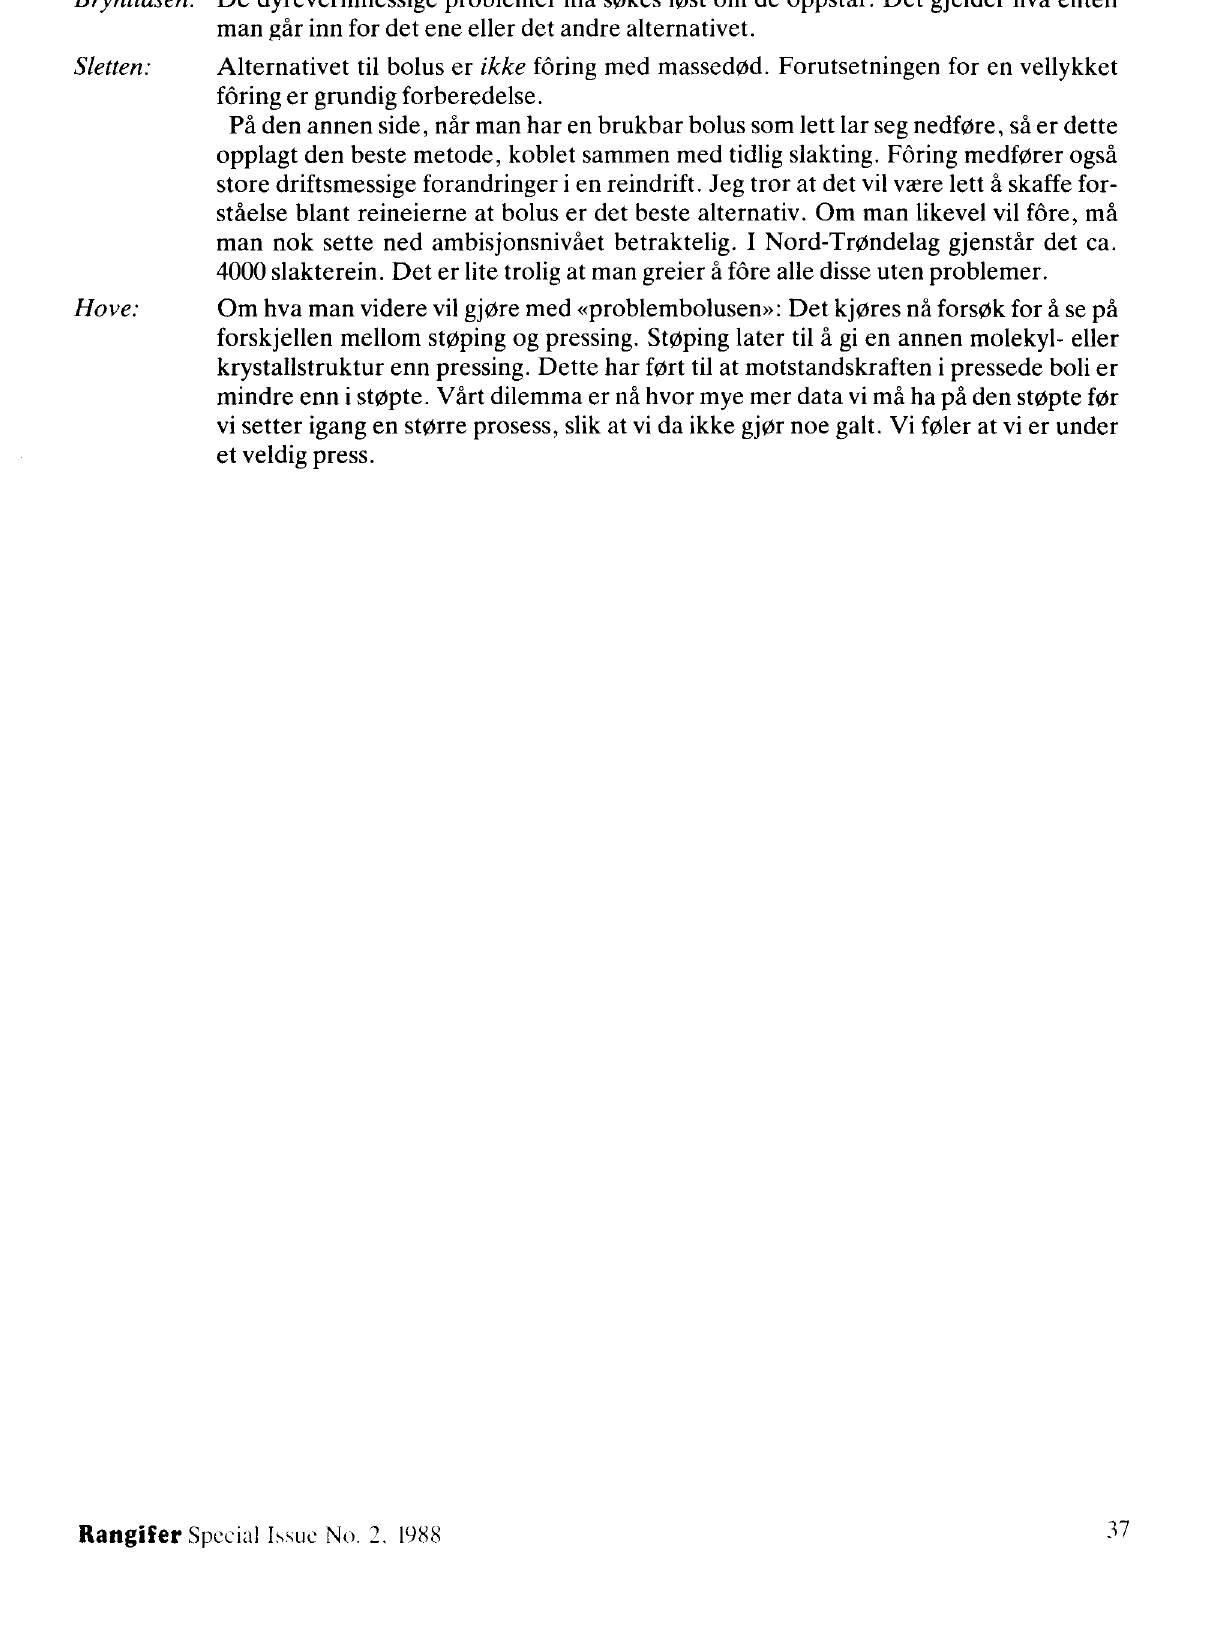
Det er uhyre viktig at man har en lik praksis og like klare retningslinjer. Brynildsen: De dyrevernmessige problemer må søkes løst om de oppstår. Det gjelder hva enten man går inn for det ene eller det andre alternativet. Sletten: Alternativet til bolus er ikke foring med massedød. Forutsetningen for en vellykket foring er grundig forberedelse.